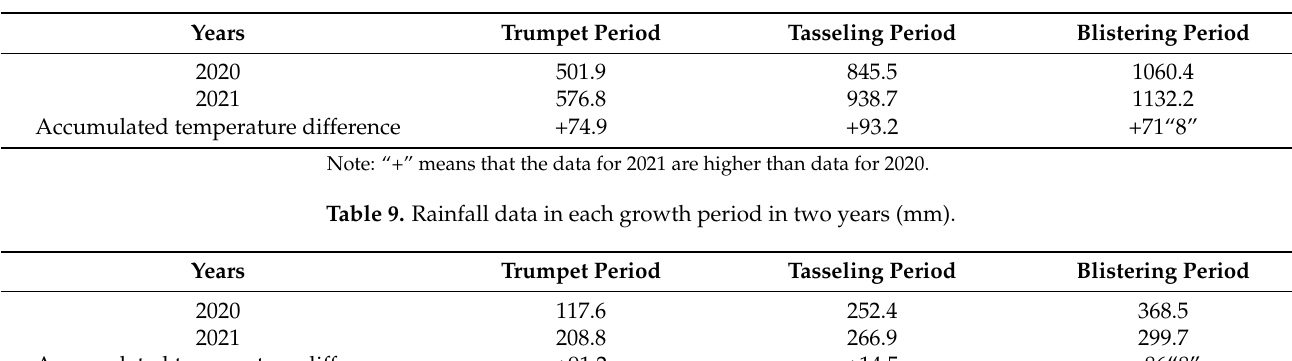
Table 8. Accumulated temperature data of each growth period in two years ( ◦ C).